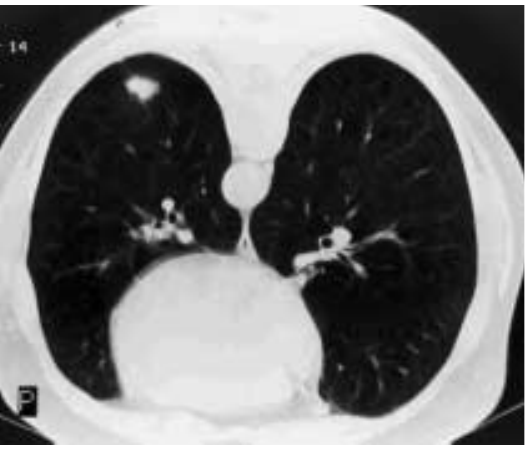
Fig ure 2 Left lower lobe solitary pulmonary nodule incidentally discovered during LVRS